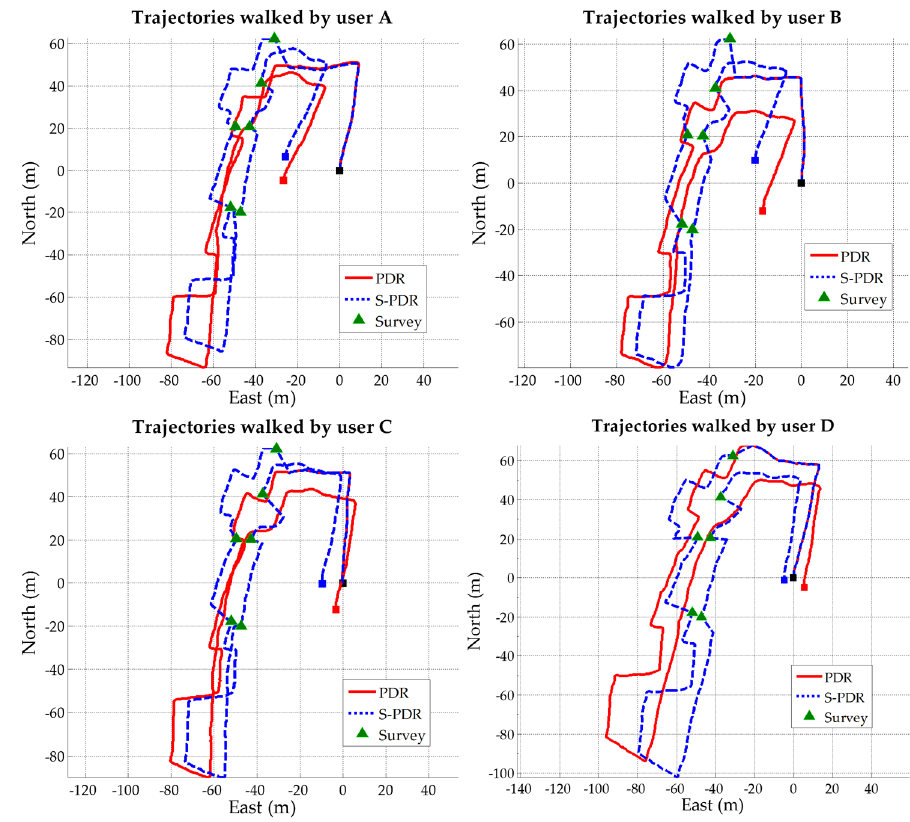
Figure 14. The trajectories of four participants using an iPhone.